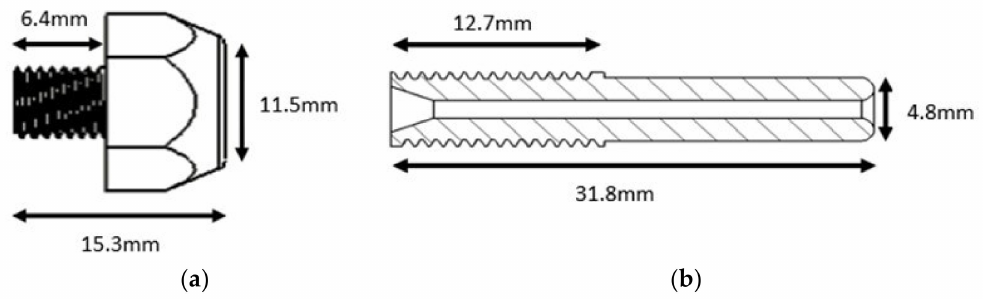
Figure 5. Nozzle designs for the composite placement head. ( a ) Original composite nozzle design; ( b ) improved composite nozzle